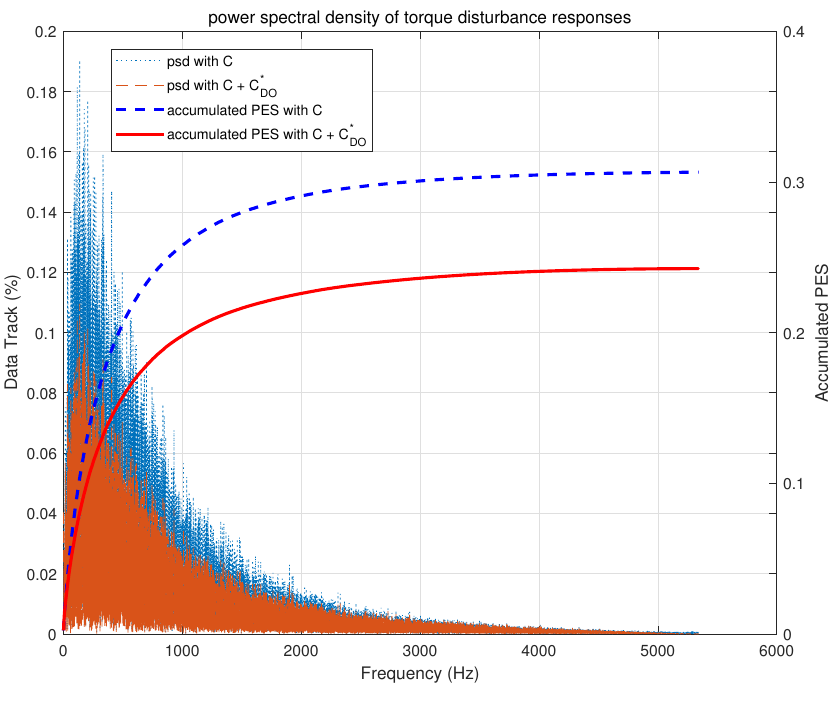
Figure 9. Compared power spectral